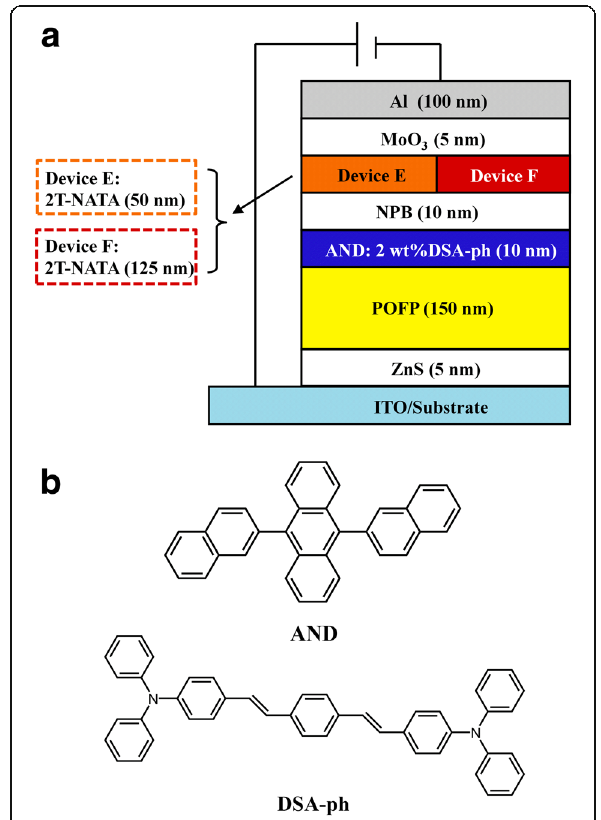
Fig. 5 a Structures of diode-pumped OSL device E and device F. b Molecular structures of the emitting materials used in the